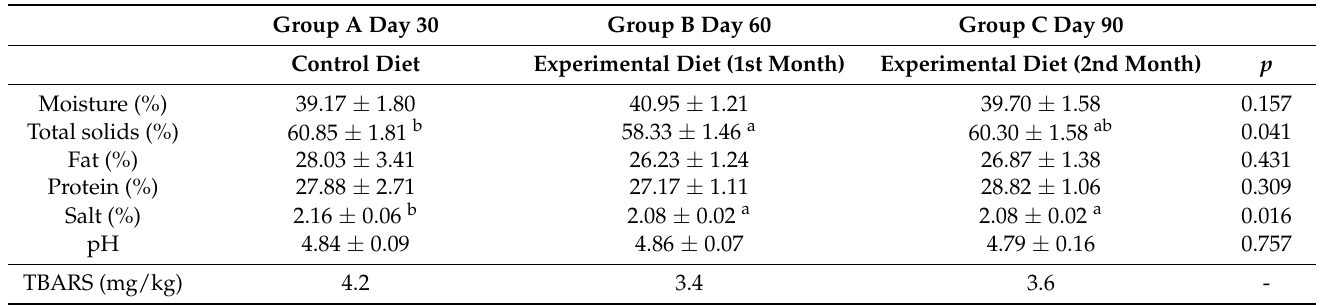
Table 4. Chemical composition and lipid oxidative markers (TBARs) of the Kefalograviera cheese samples (means ± standard